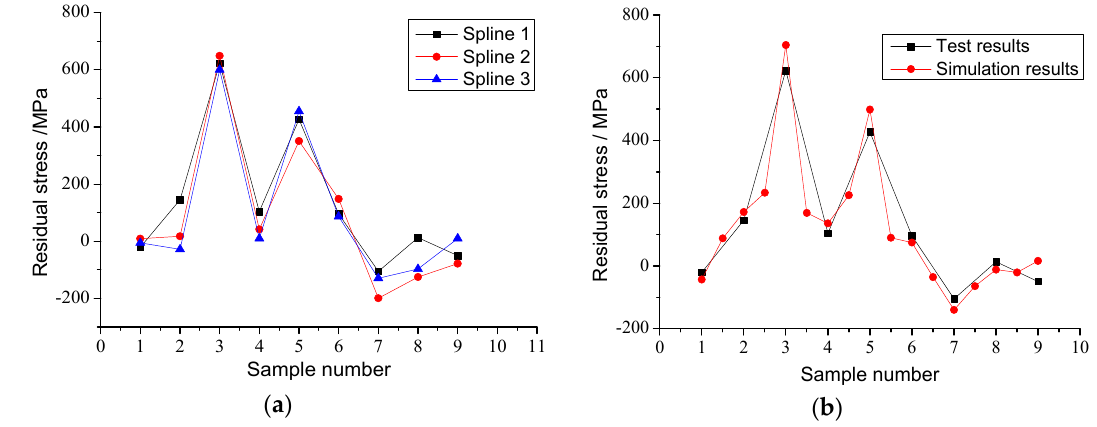
Figure 16. Comparison of residual stress measured by experiment and simulation: ( a ) residual stress of three splines; ( b ) residual stress between the test results and the simulation results.